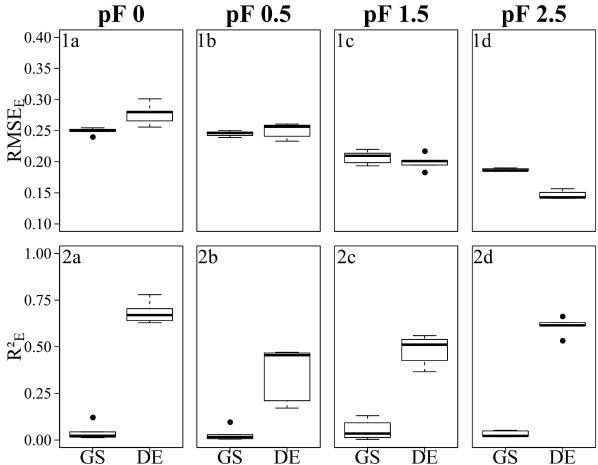
Figure 7. Error metrics of the Laipuna BRT models, showing (1a– d) the RMSE E and (2a–d) the R 2 for (1a, 2a) pF 0, (1b, 2b) pF E 0.5, (1c, 2c) pF 1.5, and (1d, 2d) pF 2.5. Each boxplot is based on five values resulting from five CV repetitions. GS refers to grid search, and DE refers to the differential evolution algorithm. Error metrics were calculated based on response variables scaled to the range [0,